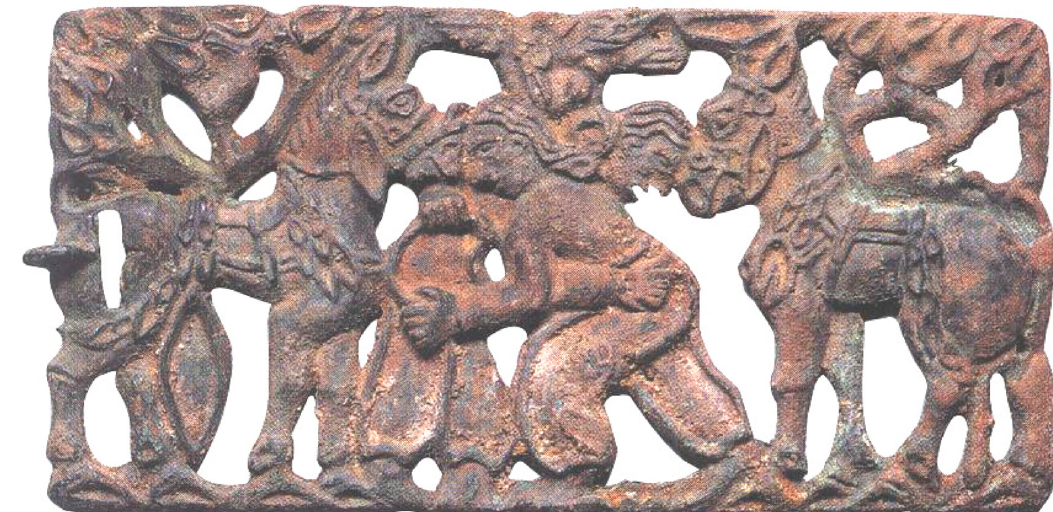
Figure 4. Plaque with wrestling scene, bronze, 13.8 × 7.1 cm, excavated from Kexingzhuang Tomb No.140, Shaanxi Province; after (So and Bunker 1995, p. 22).